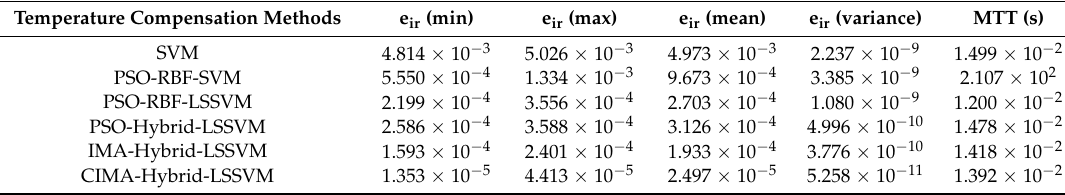
Table 3. Compensation results of training set by random partition.